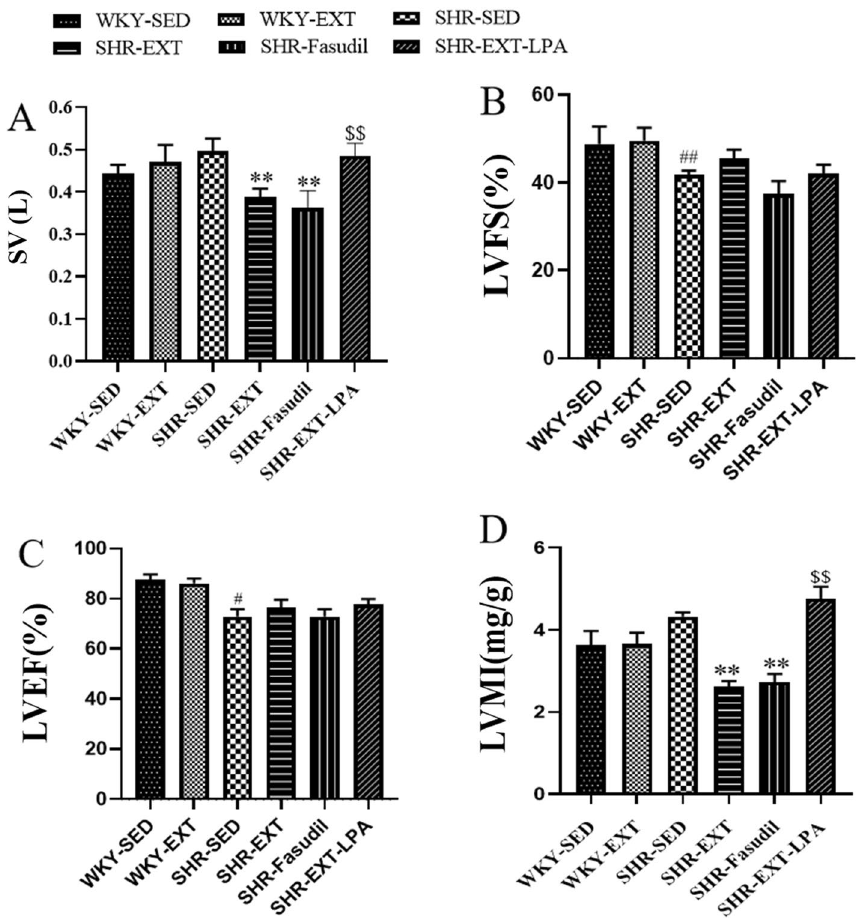
Figure 4. Effect of exercise training on left ventricular function. ( A ) SV (stroke volume); ( B ) FS (fractional shortening); ( C ) EF (ejection fraction), ( D ) LVMI (left ventricular mass index). SHR-Sed SHR control group, WKY-Sed WKY control group, SHR-ExT SHR exercise group, WKY-ExT WKY exercise group, SHR-ExT-LPA SHR exercise plus LPA group; SHR-Fasudil SHR plus Fasudil group; Data are expressed as mean ± SEM. n = 7 in each group. # P < 0.05, ## P < 0.01 vs WKY-Sed; $ P < 0.05, $$ P < 0.01 vs SHR-ExT; * P < 0.05, ** P < 0.01 vs